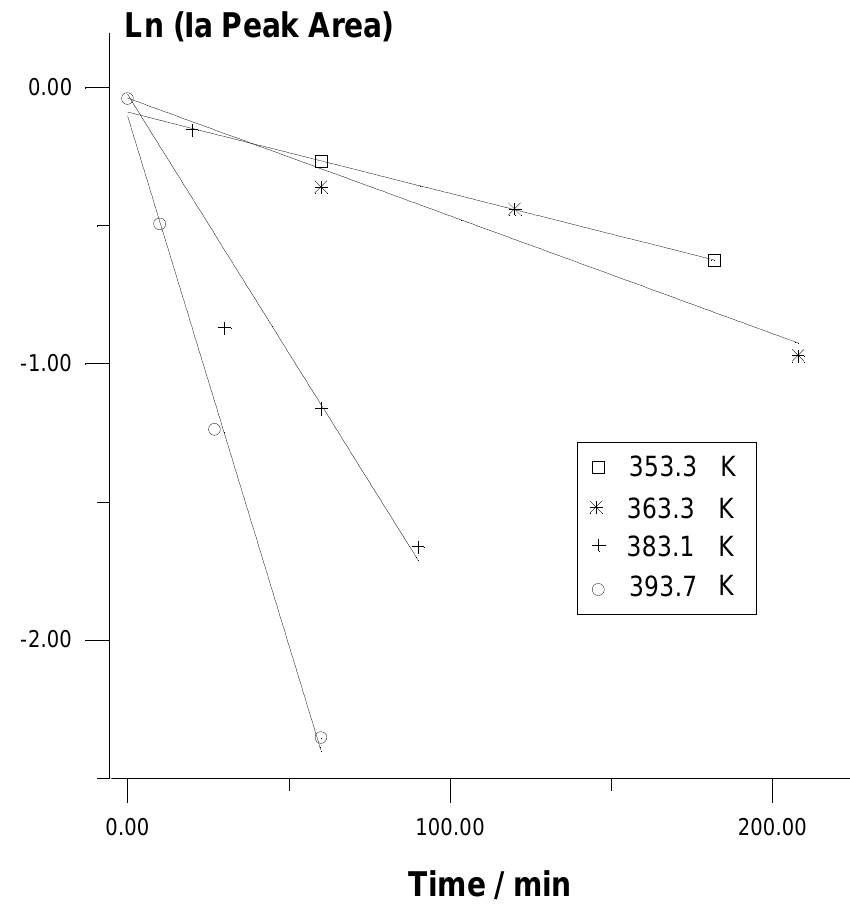
Figure 1. Representation through First-order Kinetic Plots of the Data of Typical Runs of Ia Thermolysis in Methanol Solutions at Different